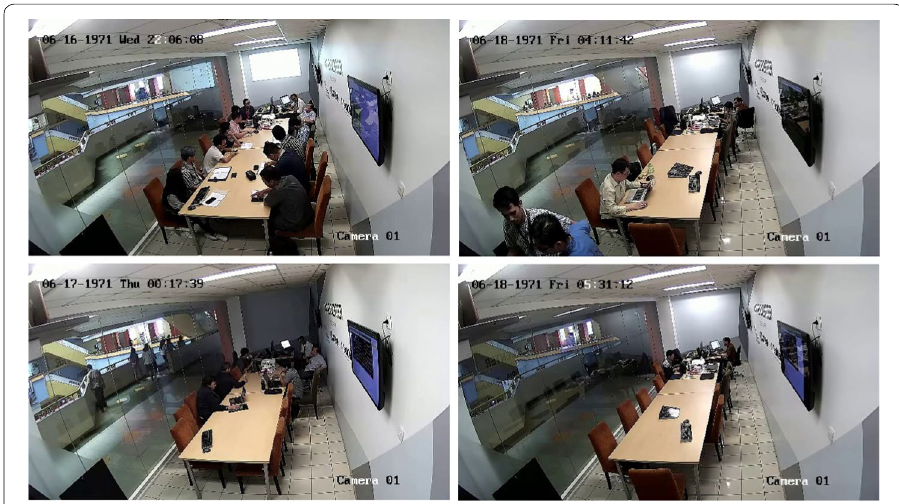
Fig. 2 Sample images in RHC